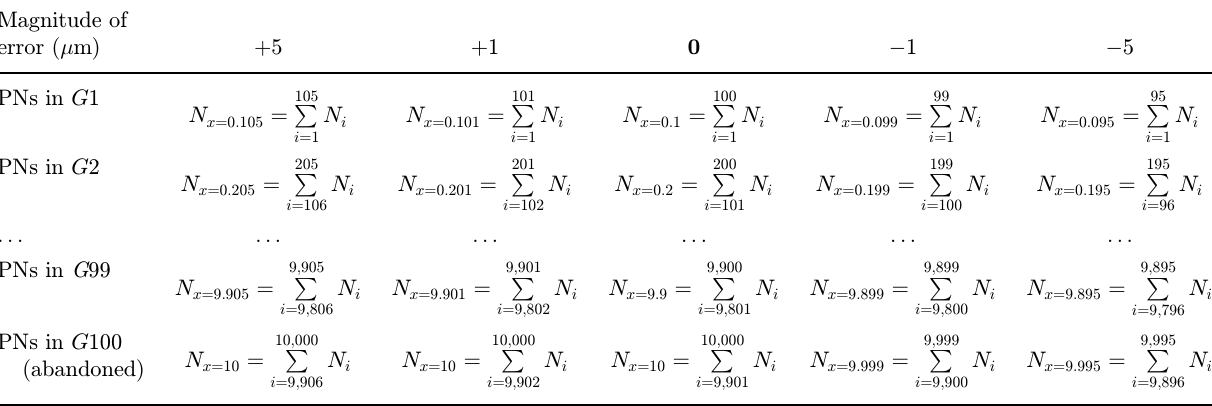
Table 3. Quantitative analyses of positioning errors.